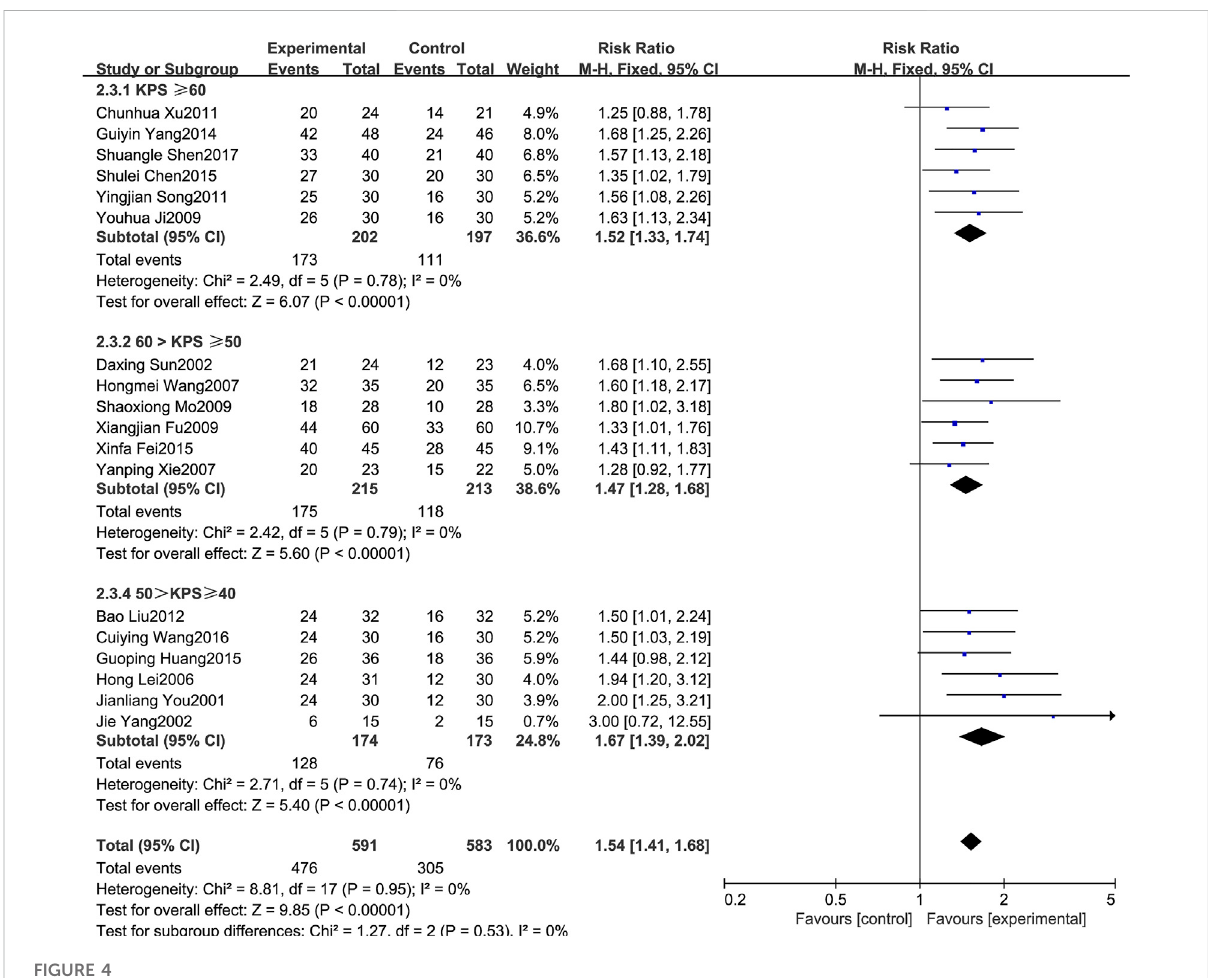
FIGURE 4 Forest plot of KPS score improvement